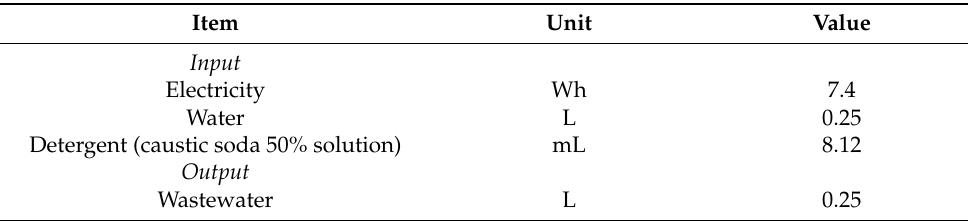
Table 3. Inventory data about the washing phase of reusable glass bottles. The values refer to the functional unit of the study.